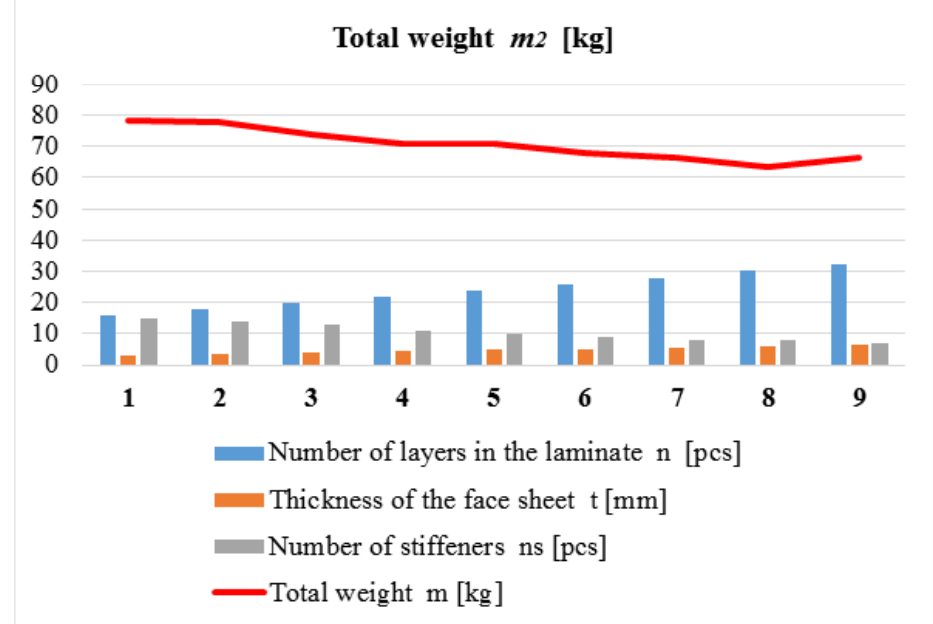
Figure 4. Result of the weight optimization.